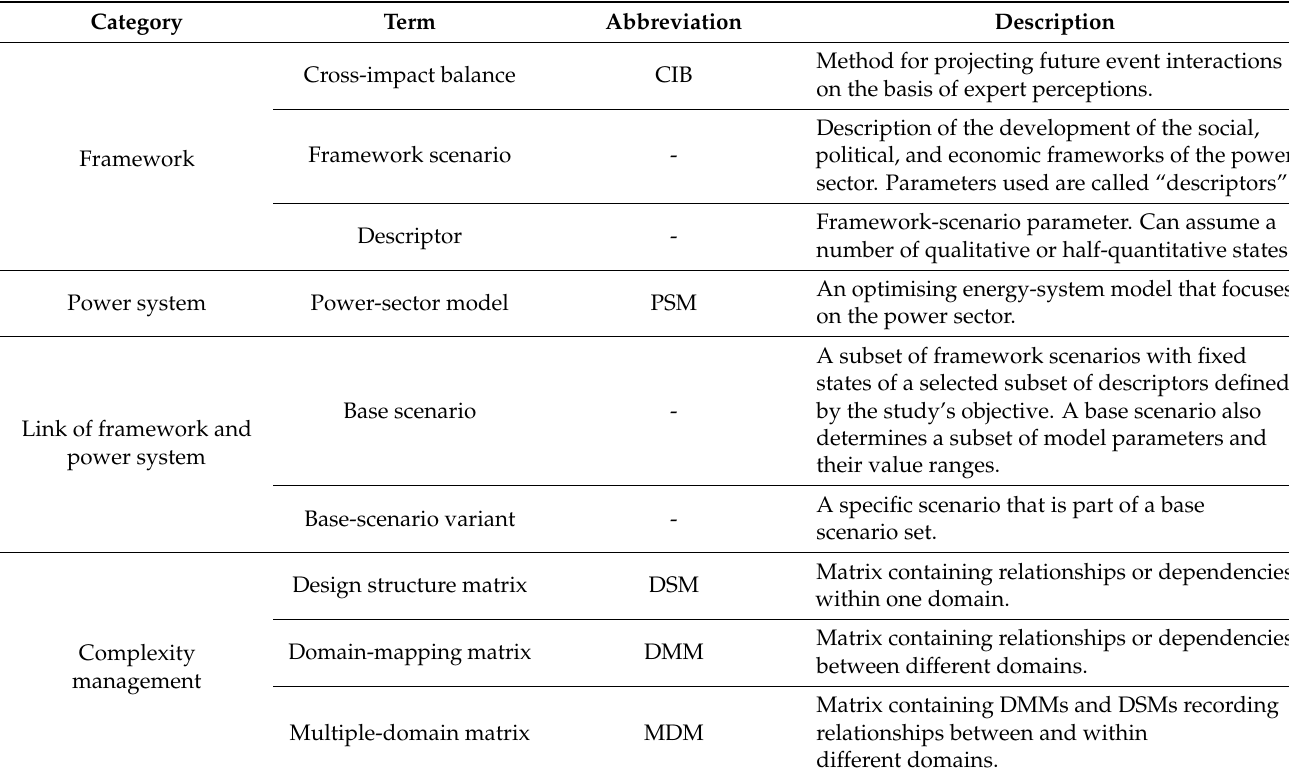
Table 1. Terms and